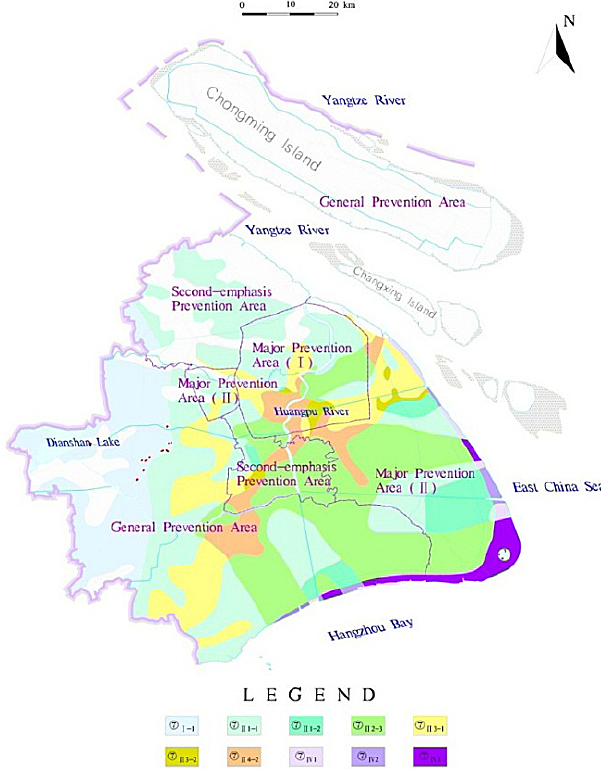
Figure 2. Prevention partition for land subsidence induced by en- gineering